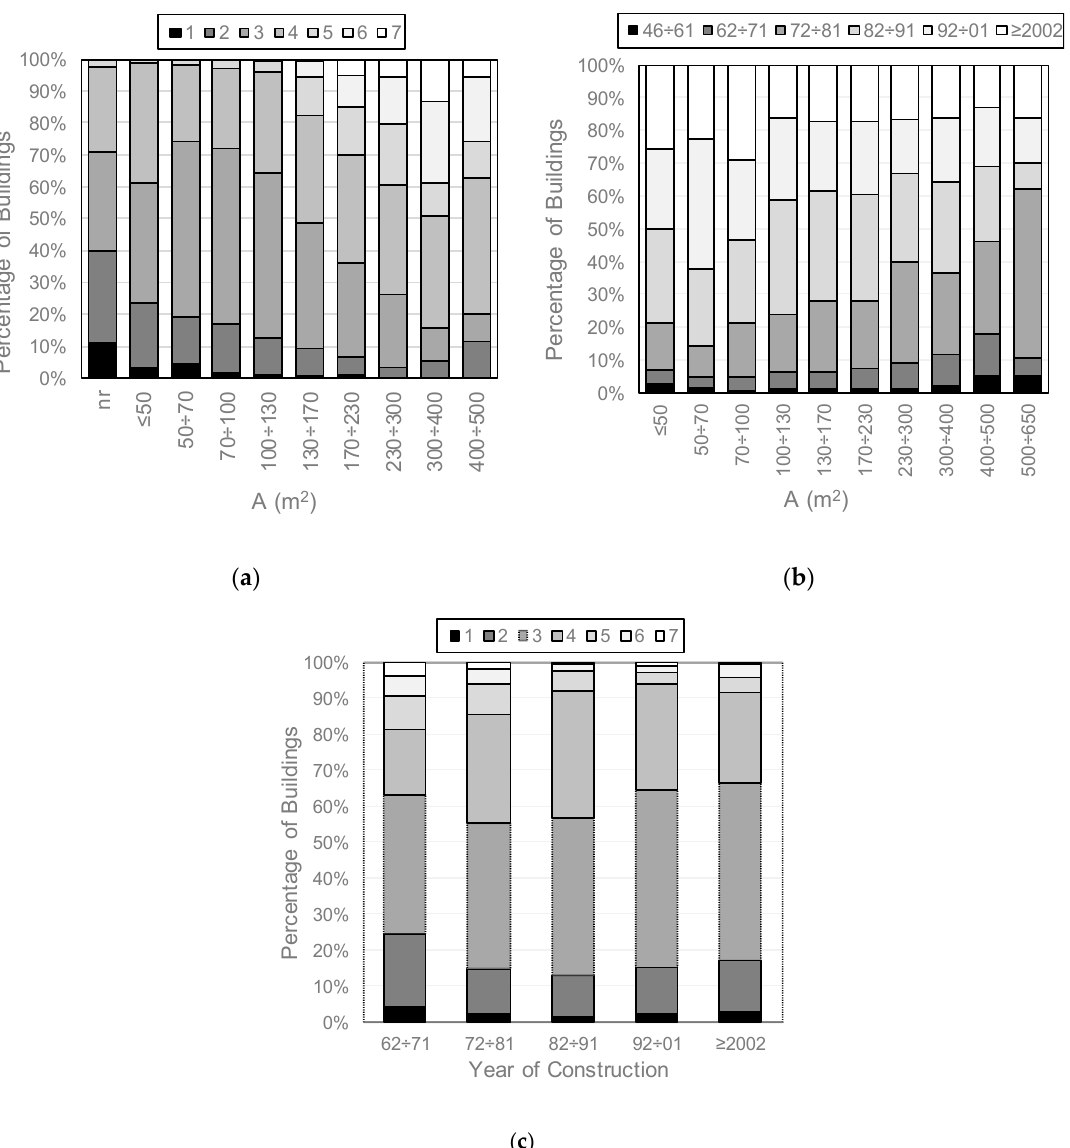
Figure 7. Cross-correlation in the frequency distributions for the analysed subset of buildings: number of storeys (from 1 to 7)—plan area ( a ), year of construction—plan area ( b ), number of storeys—year of construction ( c ).